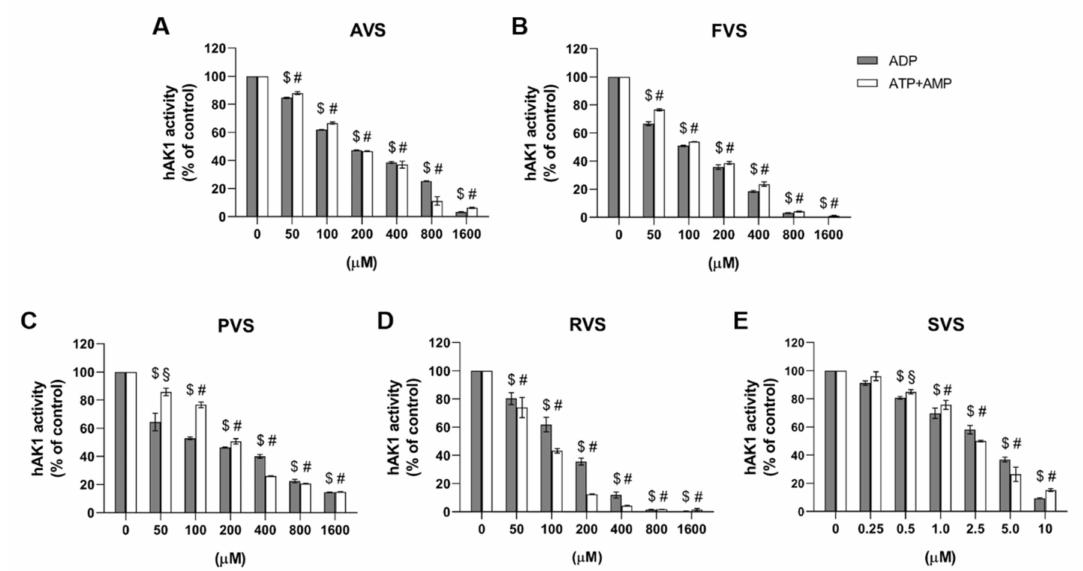
Figure 5. Effect of ( A ) atorvastatin, ( B ) fluvastatin, ( C ) pravastatin, ( D ) rosuvastatin and ( E ) simvastatin on the hAK1 enzymatic activity in the presence of ADP or ATP and AMP as substrates, 1 mM each. $ p < 0.0001 compared to the control with ADP, # p < 0.0001 and § p < 0.001 compared to the control with ATP and AMP as